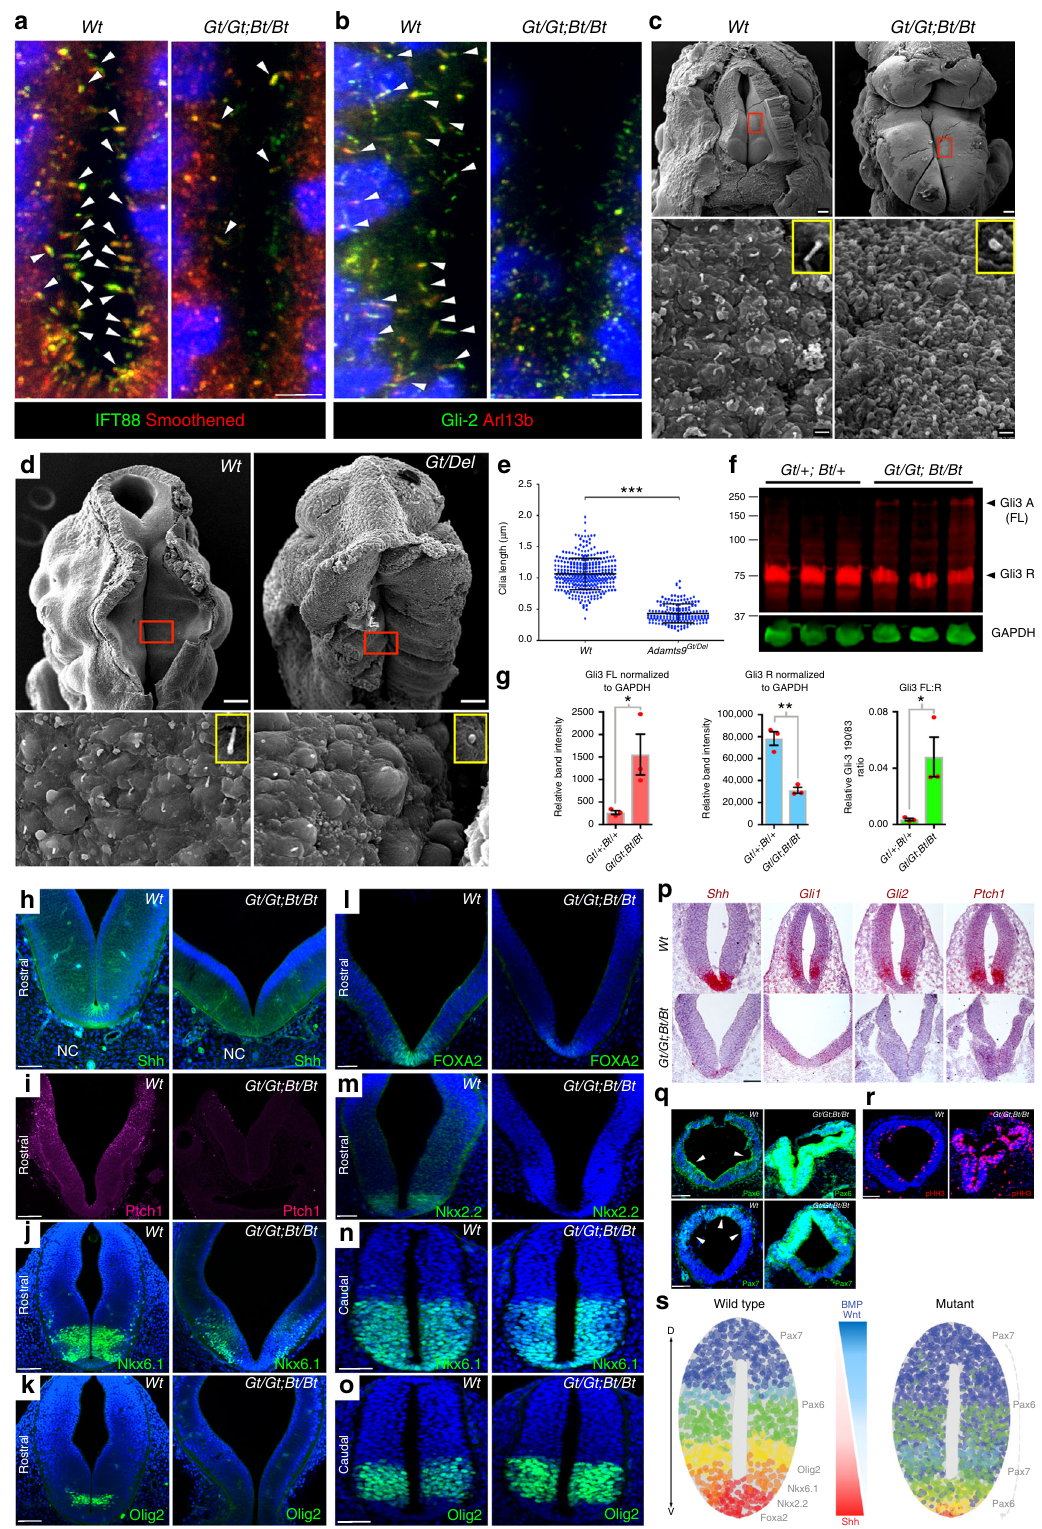
FL:RGli3 R normalized to